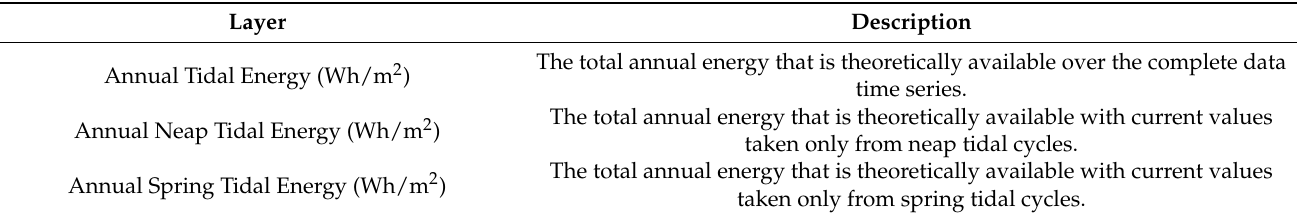
Table 5. The tidal layers and their descriptions as created for the Ocean Energy Resources group layer.